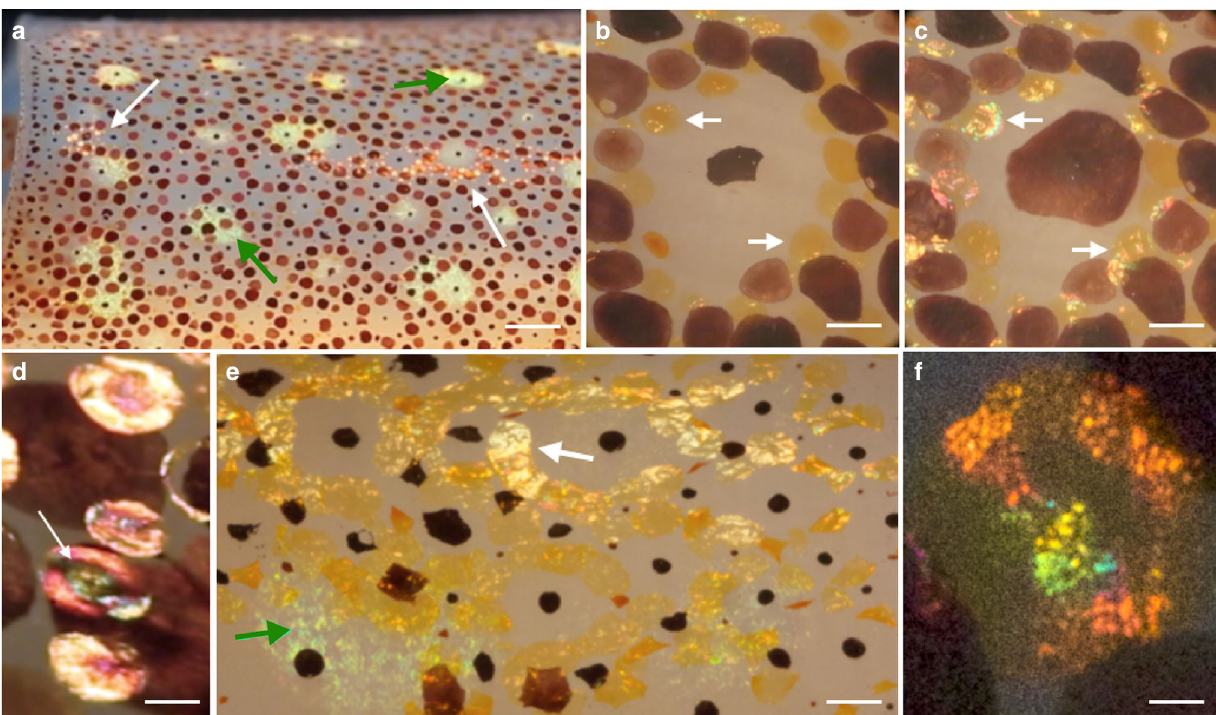
Fig. 1 Iridescence produced in chromatophores of live squid. a Low power of mantle skin; arrows indicate narrow zones of iridescence that coincide with yellow chromatocytes (white arrows) and typical iridophores (green arrows). Scale bar is 3 mm. b , c Arrows show yellow chromatophores under different lighting angles expressing different iridescence. Scale bars are 600 µ m. d Yellow chromatophores showing iridescence that coincides with the exact expansion of the chromatocyte (arrow shows concentric variation in hue seen frequently). Scale bar is 300 µ m. e Contrasting iridescence from a typical subjacent iridophore (green arrow) compared to a yellow chromatophore (white arrow). Scale bar is 1 mm. f A single yellow chromatophore showing granular and patchy iridescence. Scale bar is 100 µ